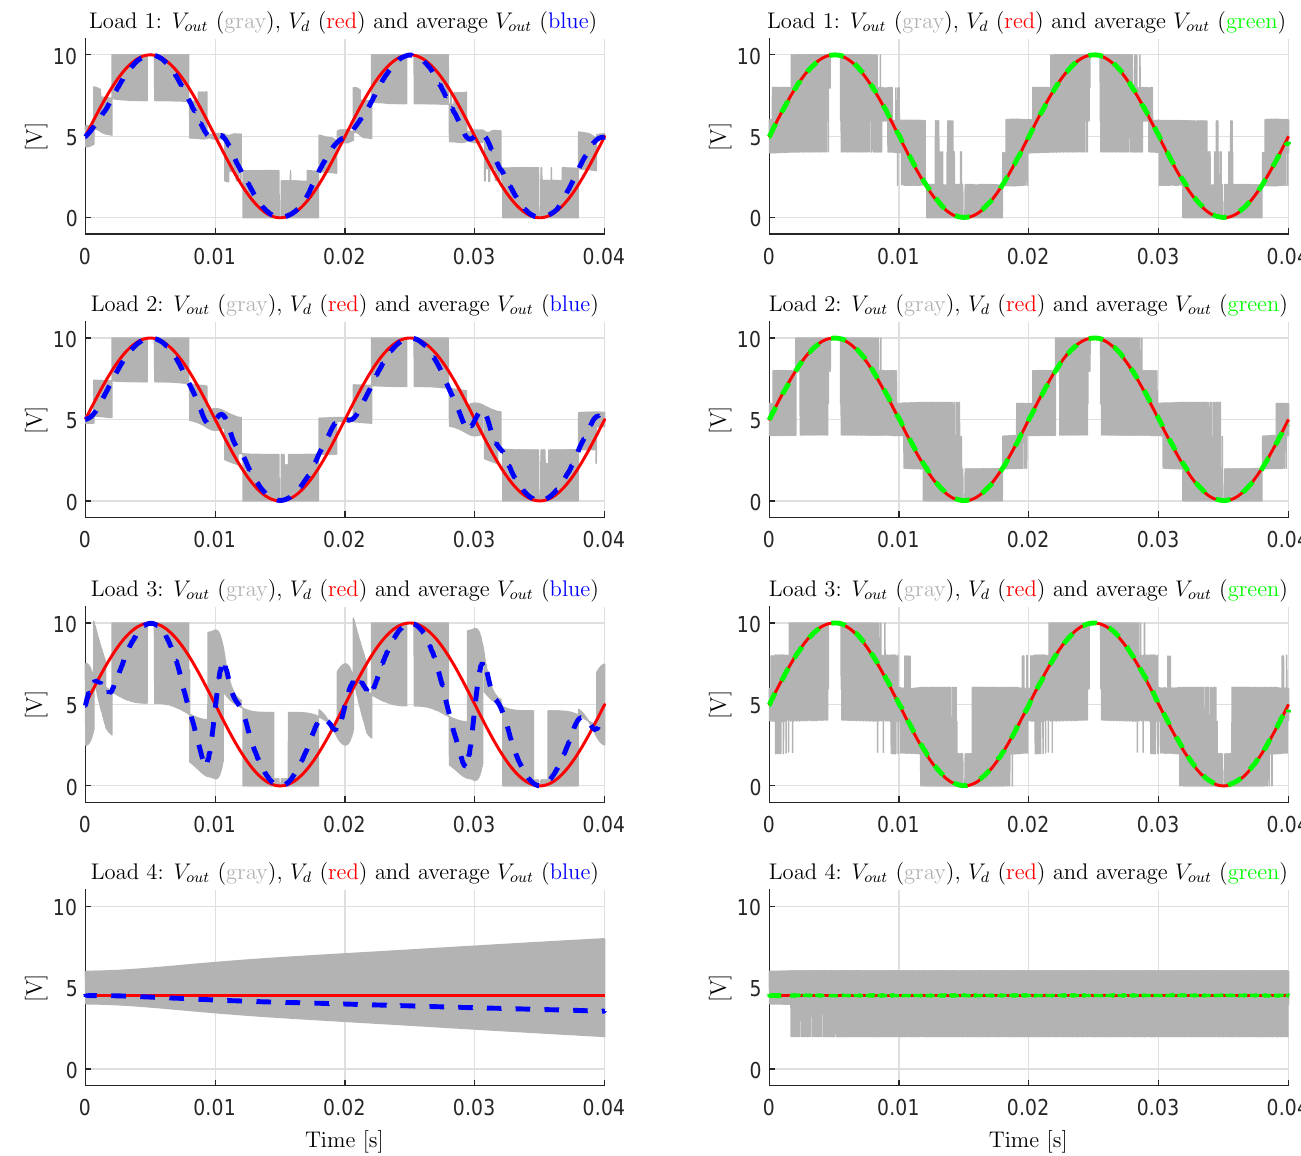
Figure 32. Left subplots: simulations using the Minimum Distance Control for V m = [ 5 4 1 ] T ; Right subplot: simulations using the Variable-Step Control for V m = [ 5 4 1 ] T